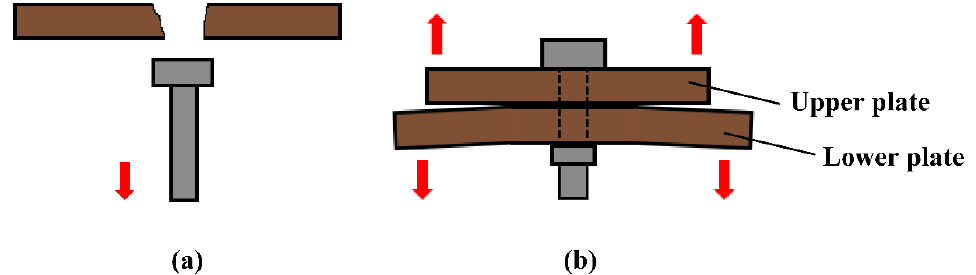
Figure 2. Common out-of-plane failure modes of ( a ) single plate bolt joint structure and ( b ) a double plate bolt joint structure.